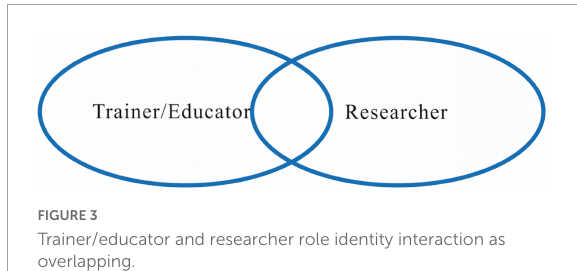
FIGURE3 Trainer/educator and researcher role identity interaction as overlapping.